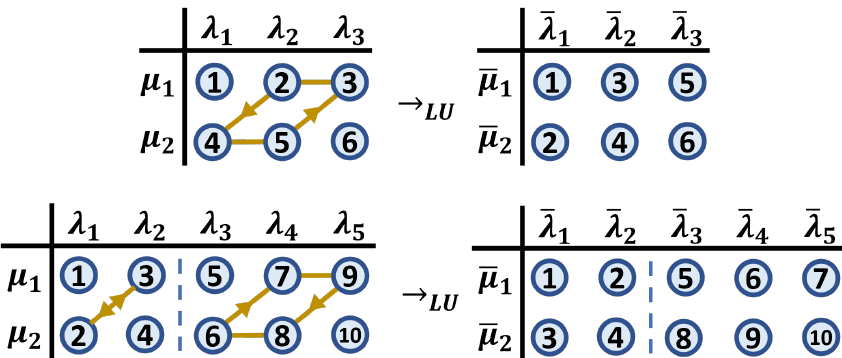
Figure 3: Non-trivial multi-state LU transformations correspond to non-trivial per- mutations of the Schmidt coefficients which preserve the tensor product structure. Here two non-trivial permutations are depicted. The circles with numbers represent µ the multiplied Schmidt coefficients (i.e. λ ) sorted into descending order. The first i j diagram corresponds to the transformation in Observation 7. The diagram below it corresponds to a "direct sum solution", as discussed after Theorem 6, that builds on this first